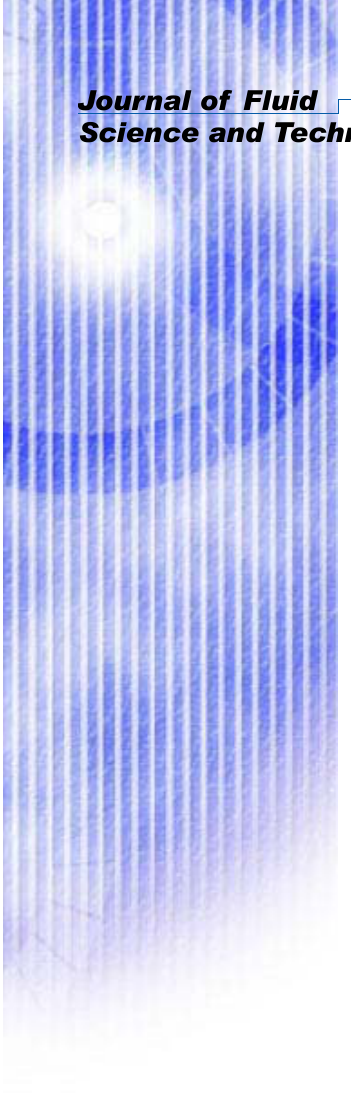
Fig.4 Comparison of velocity gradient between disturbed and undisturbed flows in the initial stage of response ( x / D = 0.1 to